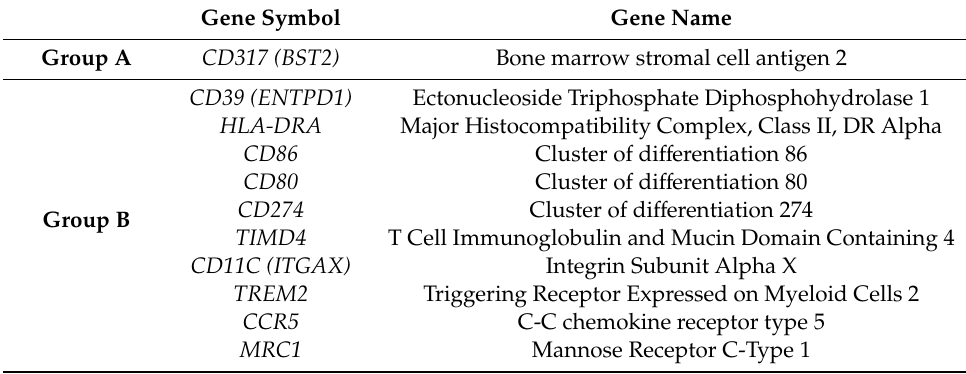
Table 10. Microglial gene signature: Group A (inactivated) and Group B (activated).